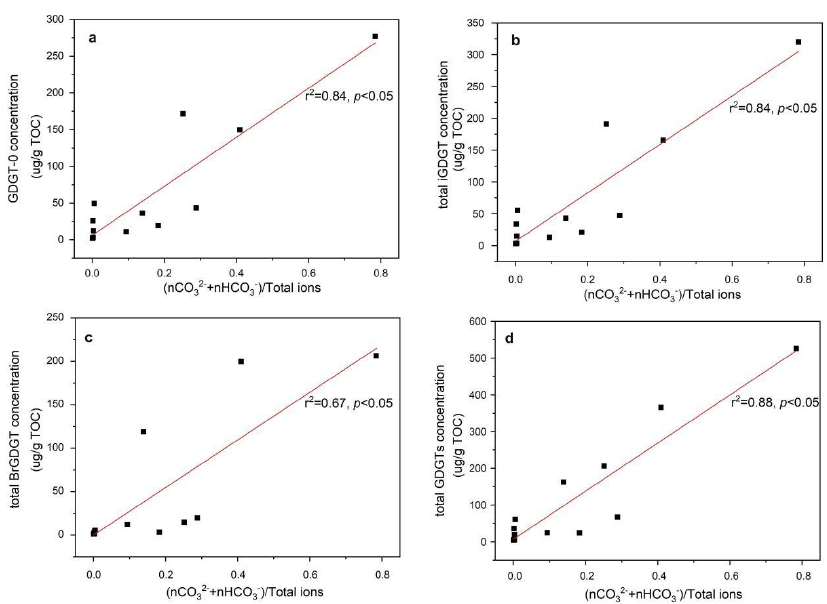
Figure 6. Plots of (nCO 32- + nHCO 3- )/total ions versus ( a ) GDGT-0 concentration, ( b ) total Igdgt concentration, ( c ) total BrGDGT concentration, ( d ) total GDGTs concentration.